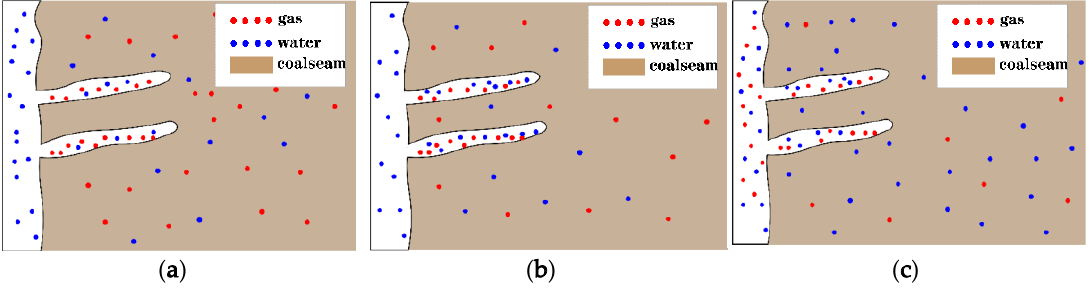
Figure 2. Water imitation process ( a ) water is in the main fracture network, ( b ) water enters secondary fractures; ( c ) water enters the